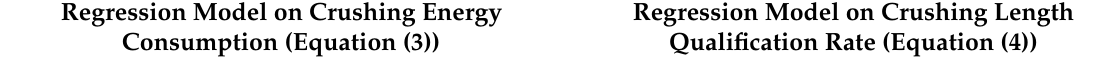
Figure 4. Parameter optimization test results. ( a ) Effect of blade rotation speed on cutting energy consumption. ( b ) Effect of blade rotation speed on crushing length qualification rate. ( c ) Effect of blade rotation radius on cutting energy consumption. ( d ) Effect of blade rotation radius on crushing length qualification rate.